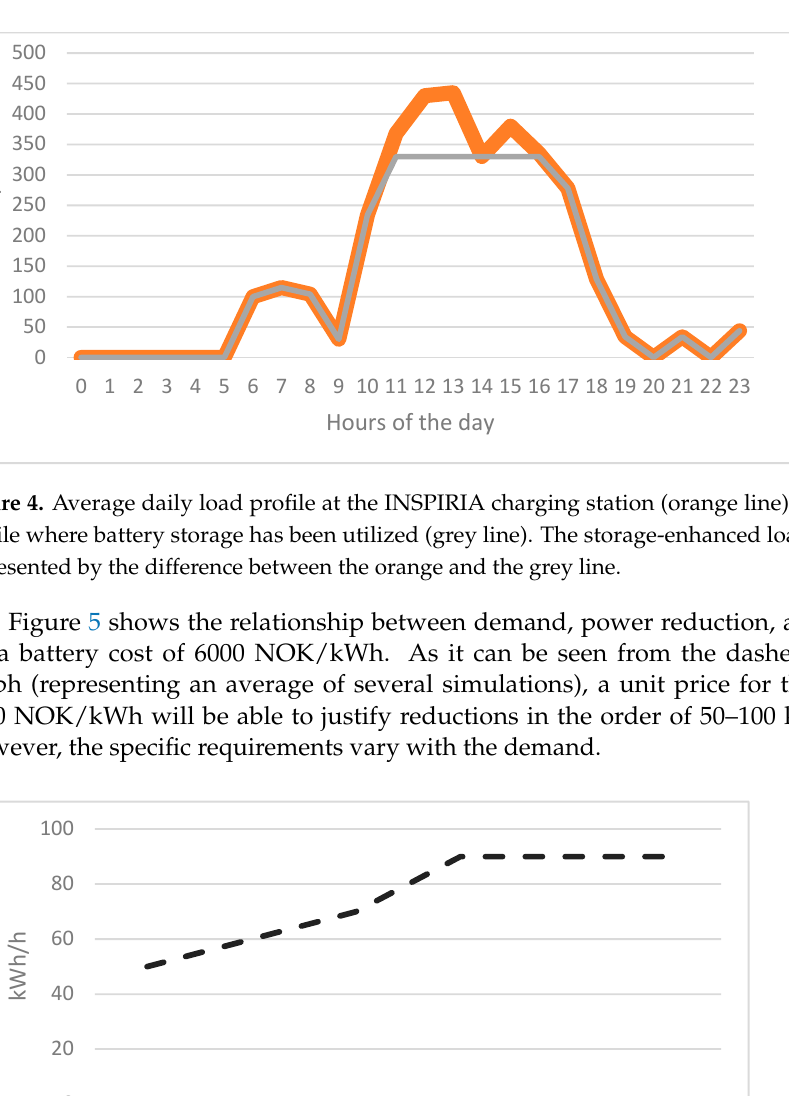
Figure 5. Battery capacity requirement under different demand levels given a battery cost of 6000 NOK/kWh. Amplification factor 1 means the current situation, while 2 refers to a situation where demand (as associated with the arrival rate in each hour) is doubled.